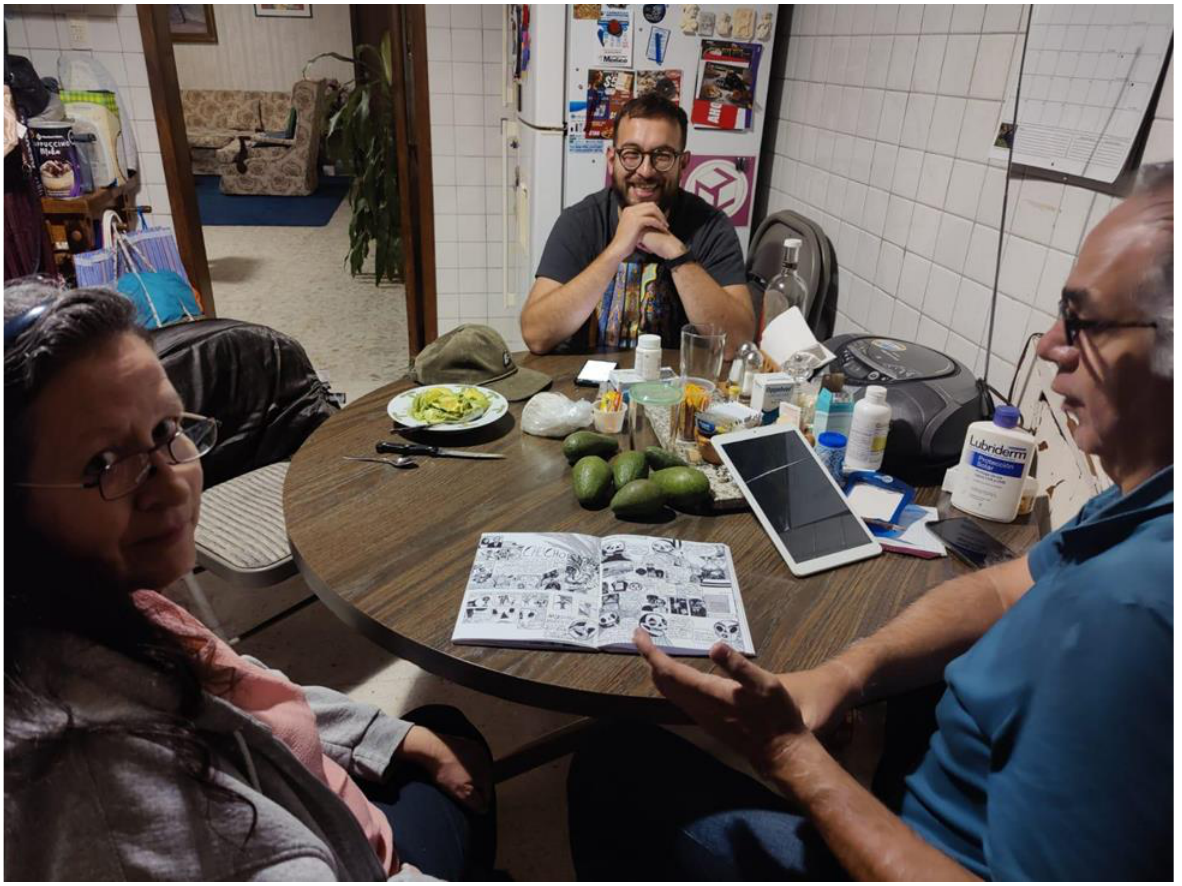
Figure 16: My aunt Rocío and Uncle Luís reading the comic. Courtesy: Gabriela Santamaría, 2022 This summer of 2022, I have been able to share with my family my comic about the stories they shared with me and everyone, including the older generation, now understands my intention to create an intersubjective study of the ways in which my family remember Chucho and Manuela. It has been an incredibly rewarding process, with the threats of the pandemic beginning to relax in Mexico, to have the time to share the comic and make sense of their reactions. I have been impressed to find that when I share the work, they begin to tell the story back to me; it continues to be a process of elicitation, much like the photos. When we have stories to tell, we will share them to those who listen. Even my great- aunt Tita understands where I am coming from but she also warned me — if I ever do release the film, only her version, – the real version! —can come out. We don’t need any more earthquakes in